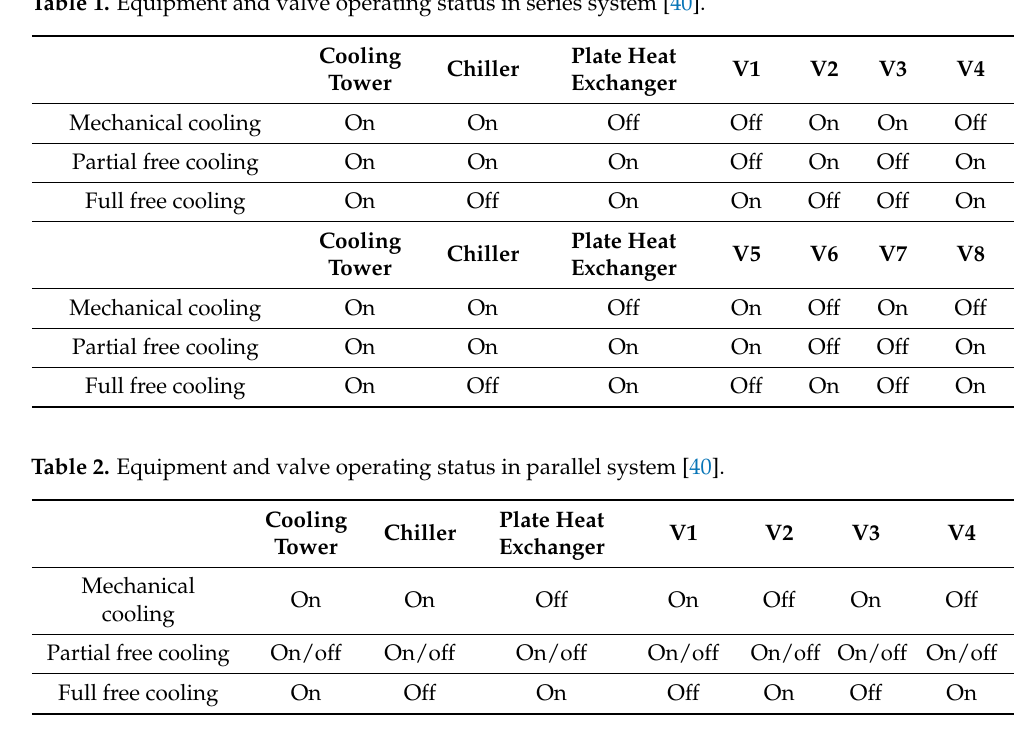
Table 1. Equipment and valve operating status in series system [40].